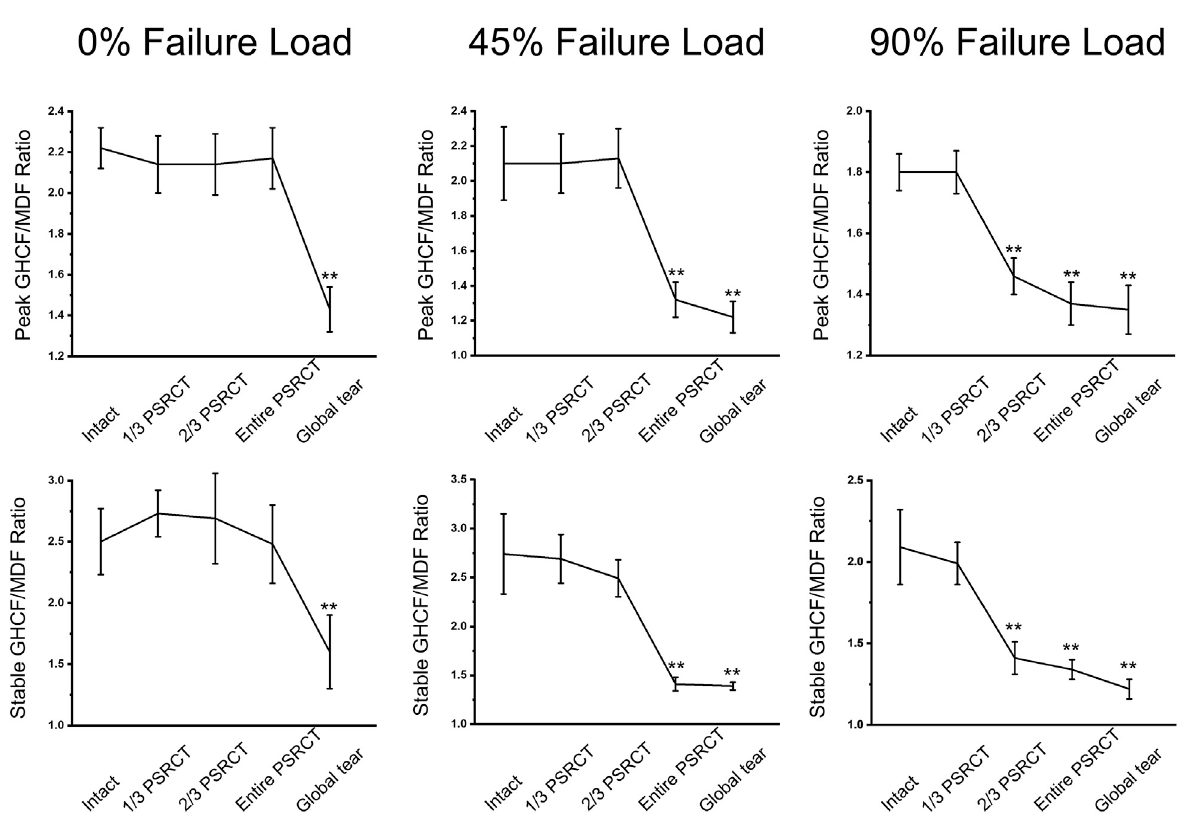
FIGURE 6 Effect of RCT on the peak and stable GHCF/MDF ratios under 0, 45, and 90% failure loads during abduction. MDF, middle deltoid force. **, a signi fi cant difference compared with the intact condition, p <